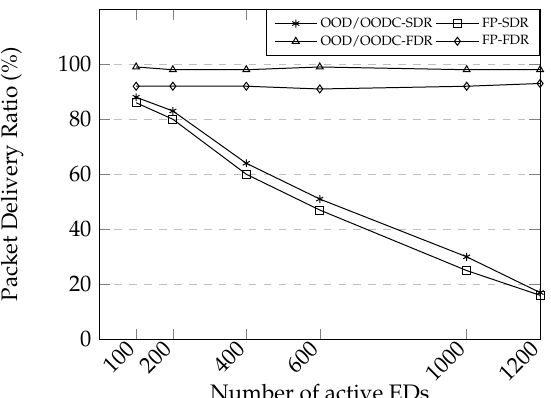
Figure 8. Performance evaluations on network topology 1. Reliability comparison between OOD, OODC, and FP forwarding on slow data rate and fast data rate scenarios. Here, multi-reception approach improves the reliability of OOD and